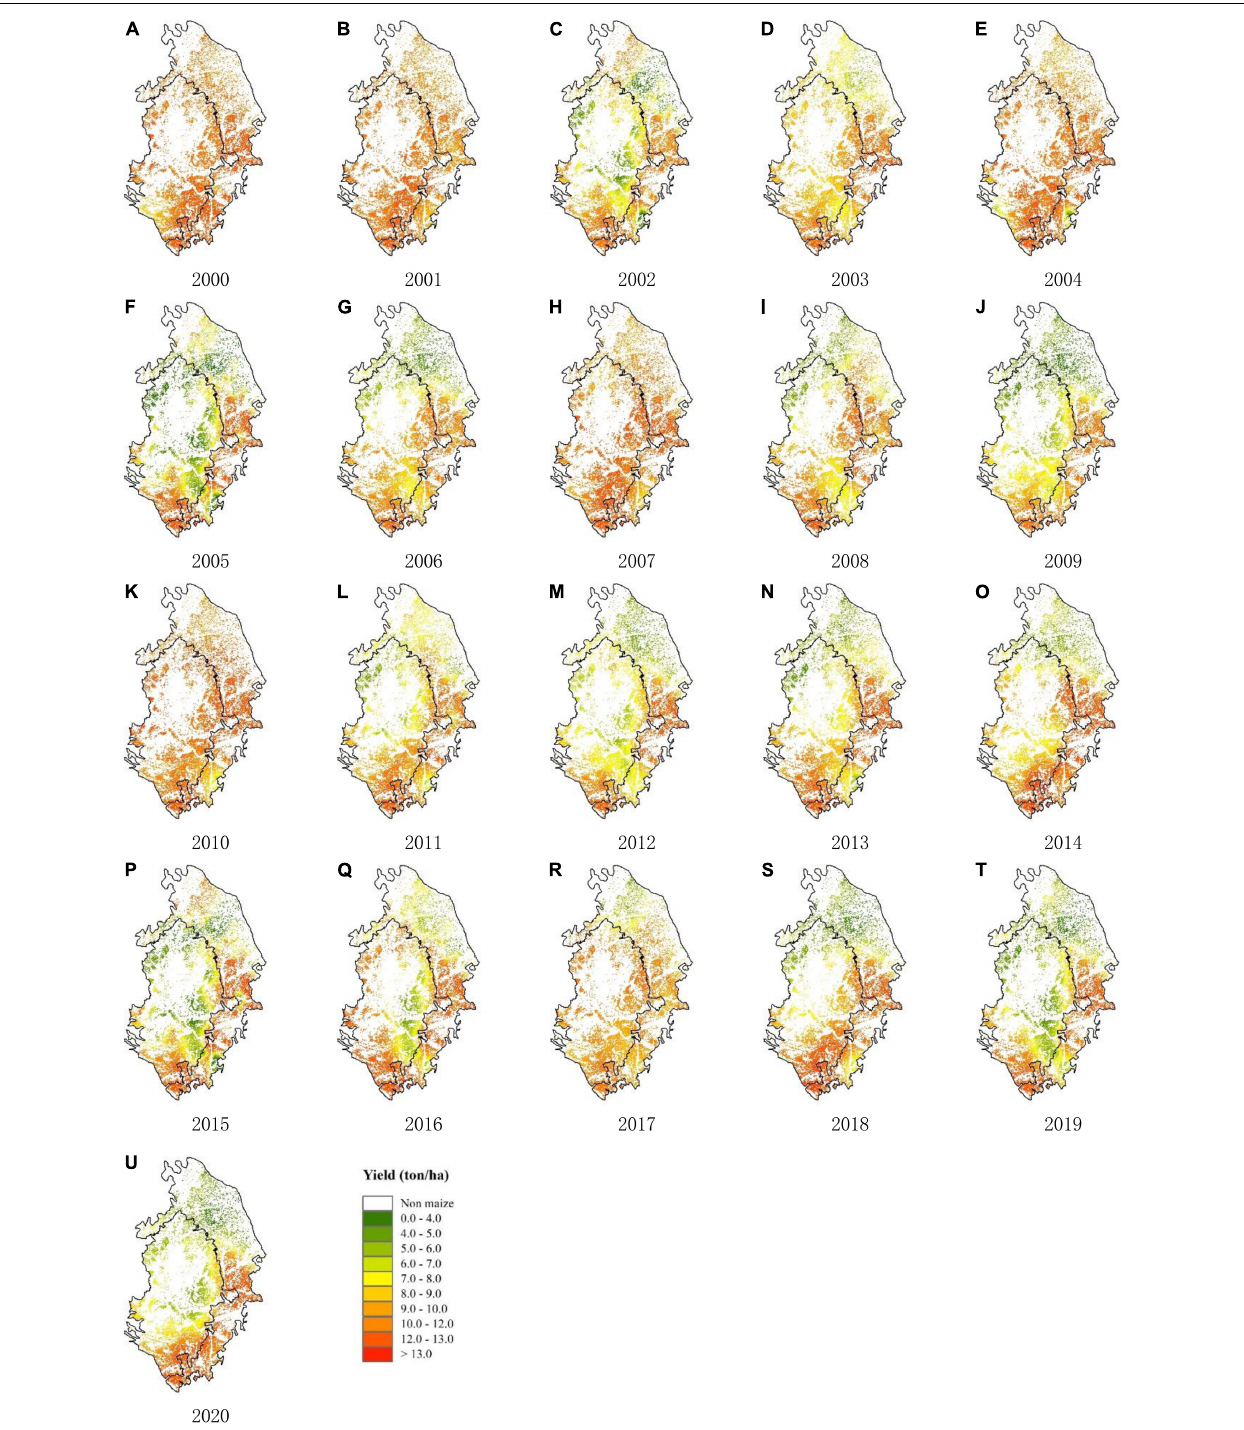
phenological parameters that led to discrepancies between the simulation and reality. It should be noted that remote sensing data can reflect real surface information only when the spatial